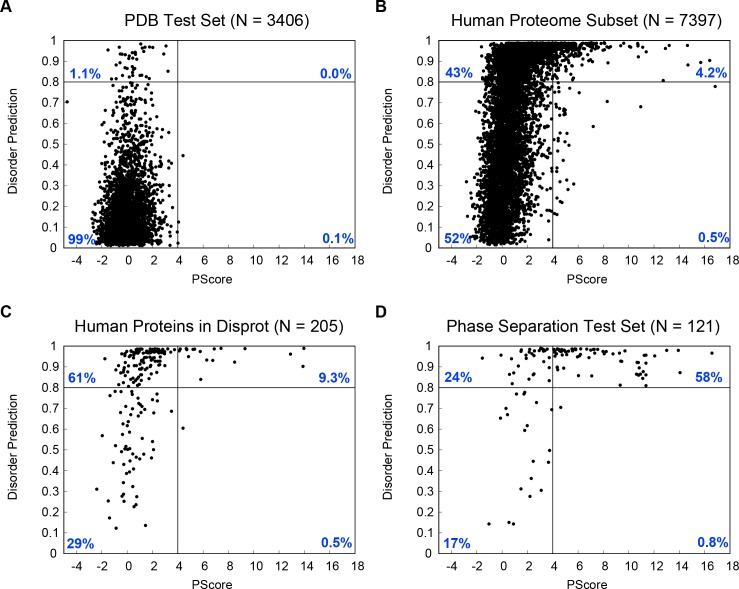
Contrasting behavior of disorder prediction algorithms and the phase separation prediction.Disopred3 (Jones and Cozzetto, 2015) derived disorder predictions are shown on the y axis and PScores are shown on the x axis for four different test sets, (A) our PDB test set, representing a negative set for both phase separation and disorder, (B) a random sample of 4385 sequences from the human proteome, (C) the subset of the human proteome annotated as containing disorder in the Disprot database (Piovesan et al., 2017), representing a positive set for disorder, and (D) our full phase separation test set. Results are split into four categories separated by PScore = 4 and Disorder = 0.8, with the percentage of sequences in each category inset in blue. The majority of known phase-separating proteins are associated with disorder, and are predicted to be disordered, but sequences predicted to phase separate represent a small subset of both the known and the predicted disordered proteins.